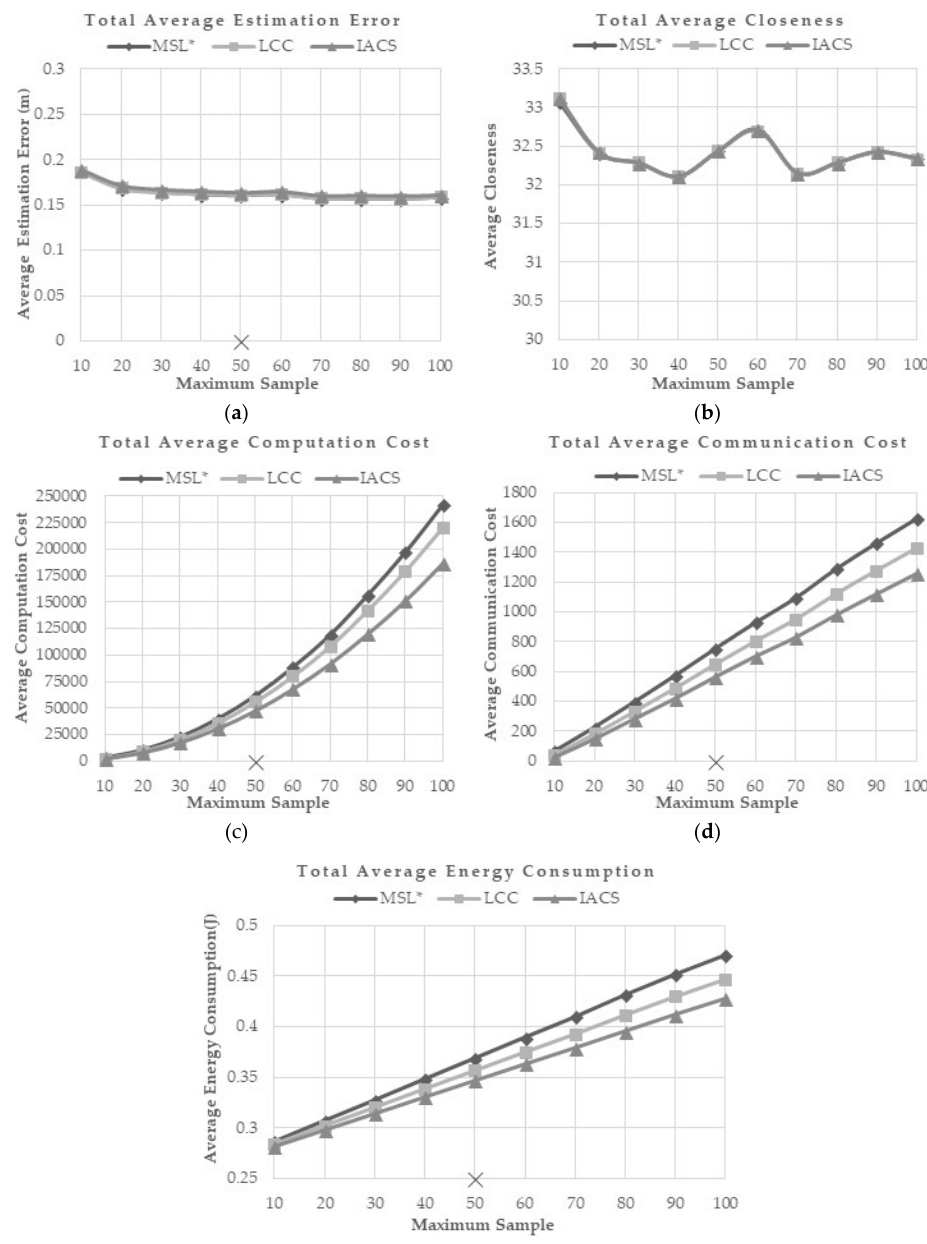
Figure 6 . ( a ) Total Average Estimation Error, ( b ) Total Average Closeness, ( c ) Total Average Computation Cost, ( d ) Total Average Communication Cost, and ( e ) Total Average Energy Consumption for Default Parameter Scenario.